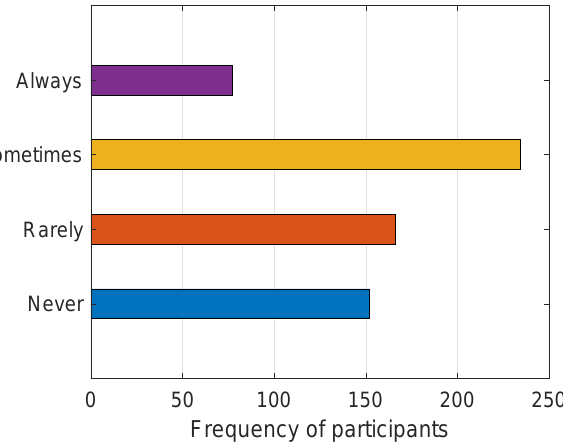
Figure 9. Difficulties in remembering